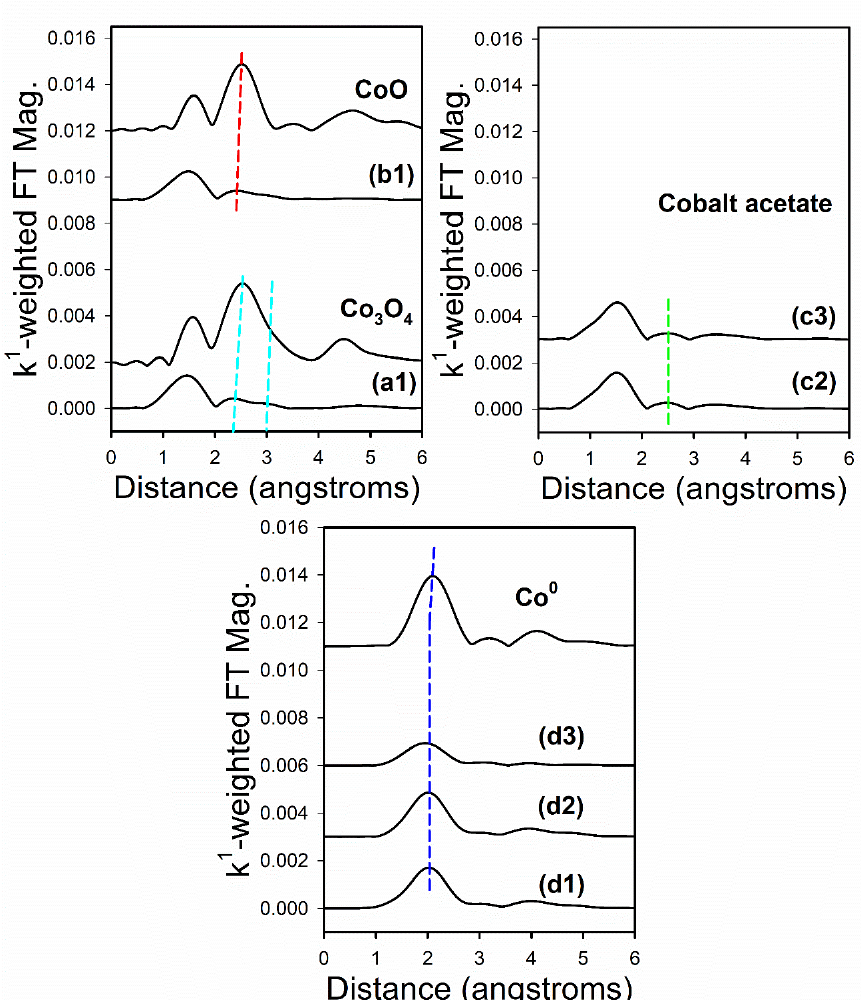
Figure 9. EXAFS snapshots of references for Co 3 O 4 , CoO, and Co 0 obtained from TPR-XANES trajectory of the calcined 25% Co/Al 2 O 3 reference catalyst and for cobalt acetate obtained in the initial spectrum of the uncalcined unpromoted 12% Co/SiO 2 catalyst. EXAFS snapshot spectra for 12% Co/SiO 2 prepared from cobalt acetate along the TPR trajectory include (1) calcined catalyst, (2) uncalcined catalyst and (3) uncalcined catalyst with 0.5% Pt promoter at ( a ) the point of maximum spinel (e.g., Co 3 O 4 ), ( b ) the point of maximum CoO following the reduction of the spinel, ( c ) the point of maximum cobalt acetate content, and ( d ) the point of maximum Co 0 content following TPR. Dashed lines emphasize the presence of Co-Co coordination in (green) cobalt acetate, (cyan) the cobalt spinel, (red) CoO, and (blue) Co 0 nanoparticles.